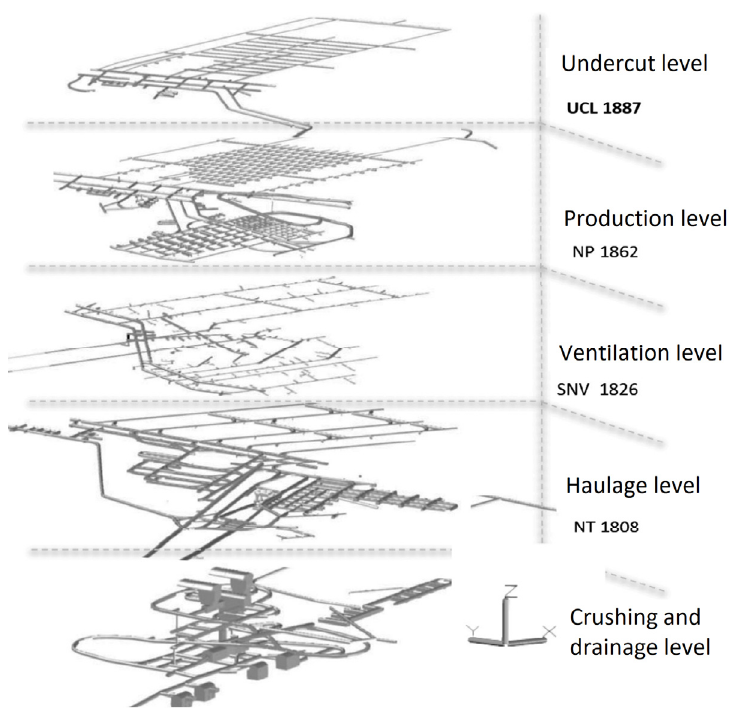
Figure 7. Isometric view of the initial new level mine project, El Teniente [51].